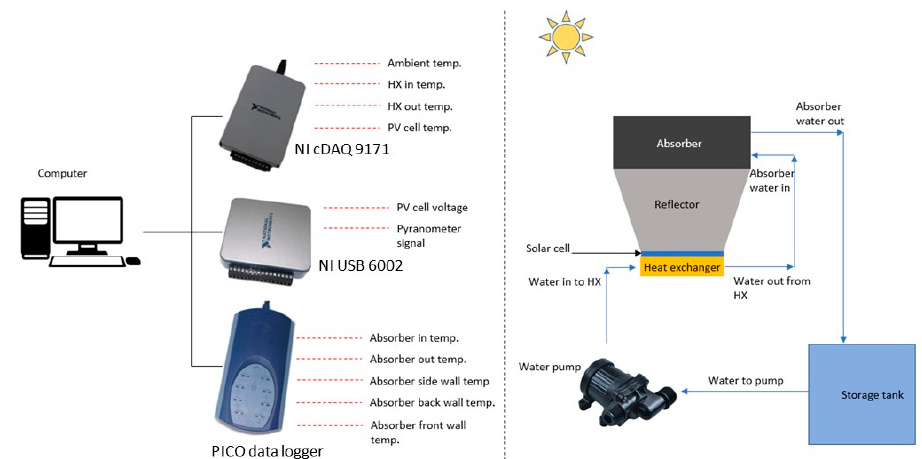
Figure 12. Left side—Depicts the instruments utilized for acquiring their respective temperature and voltage signals. Right side—Depicts the flow path of water through the module.